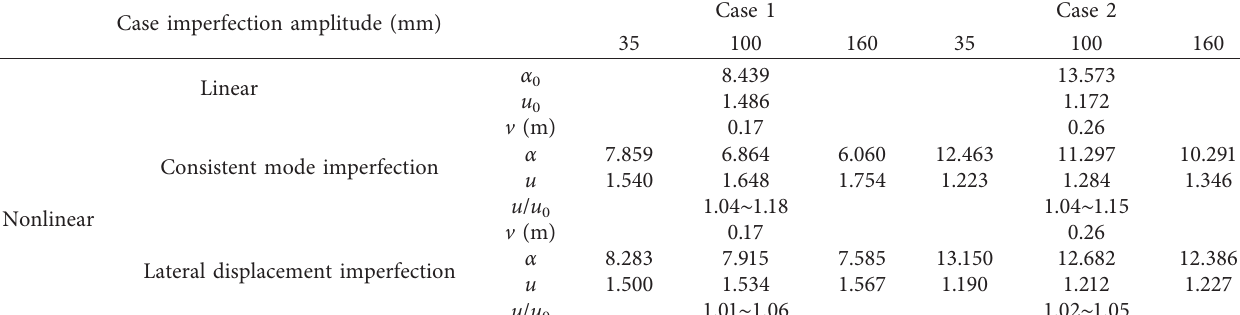
Table 1: Values of α and u for different imperfection amplitudes.